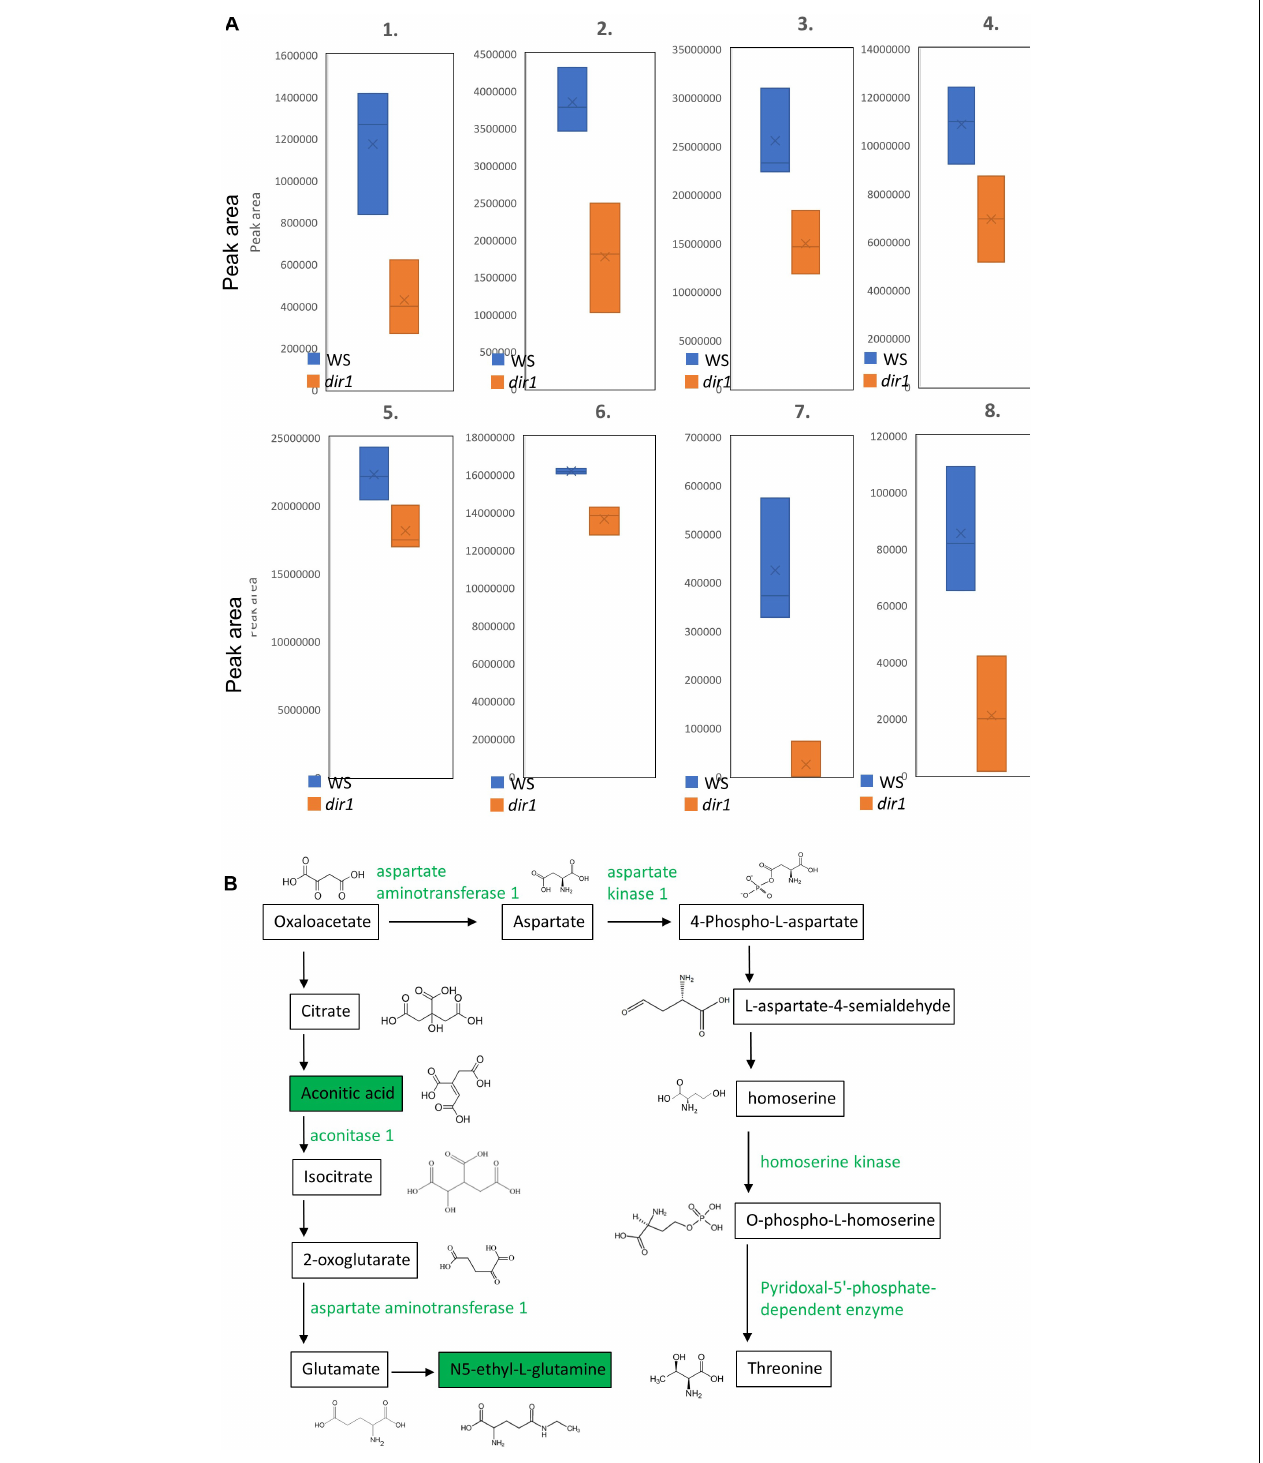
FIGURE 6 | Amino acid biosynthesis pathways with differential metabolites and proteins in leaves of wild type and dir1 mutant primed by Pst DC 3000 treatment. (A) Box plots showing lower abundance of six proteins and two metabolites in the glutamate and threonine biosynthetic pathways. 1. aspartate kinase 1; 2. homoserine kinase; 3. pyridoxal-5 (cid:48) -phosphate-dependent enzyme; 4. argininosuccinate synthase; 5. aconitase 1; 6. aspartate aminotransferase 1; 7. aconitic acid; 8. N5-ethyl-L-glutamine. (B) KEGG pathways of metabolites/proteins related to glutamate and threonine that are differentially abundant in wild type versus dir1 primed leaves. Green color indicates decreased